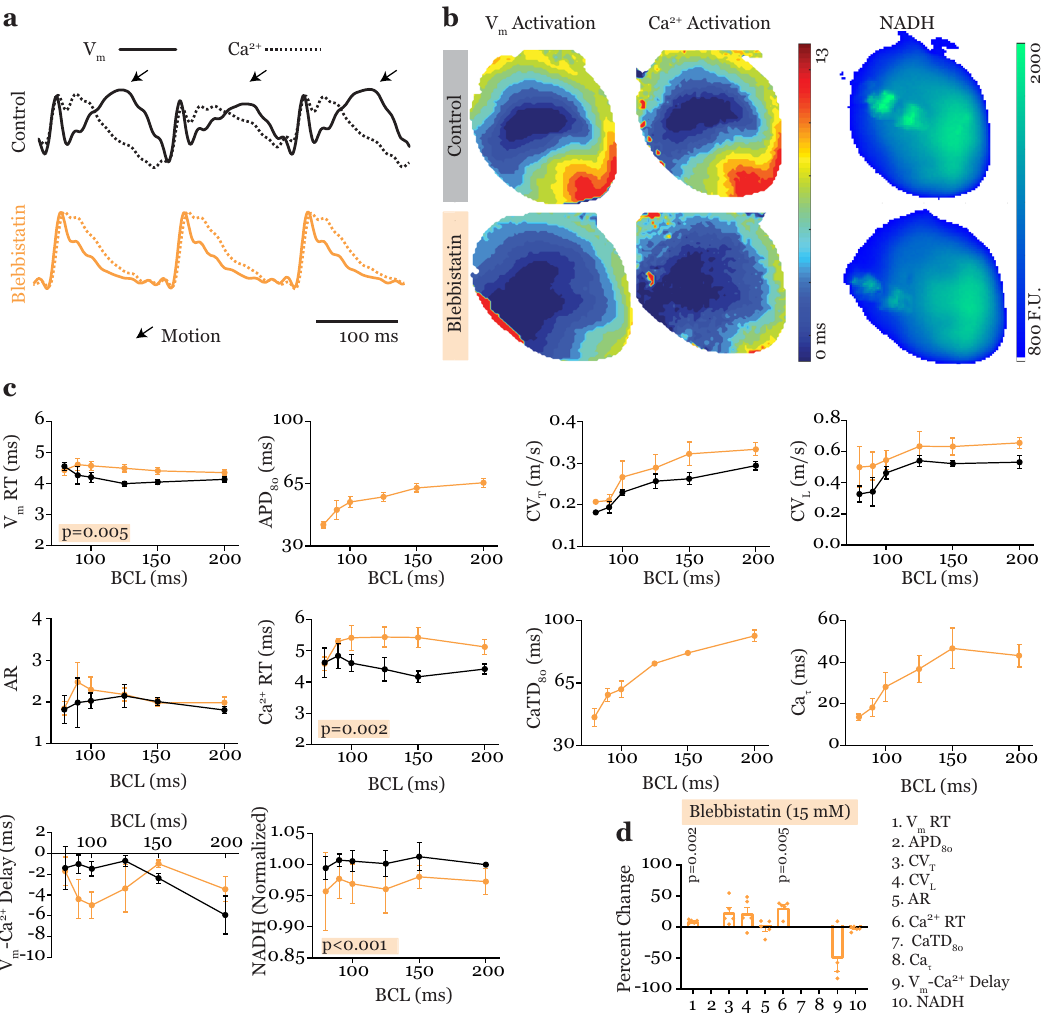
Fig. 2 Electromechanical uncoupling in triple-parametric optical mapping. a Representative traces of V m and Ca 2 + (solid and dotted traces, respectively) were recorded without (Control, black) and with the electromechanical uncoupler Blebbistatin (15 μ M, orange). b Representative V m activation maps (left), Ca 2 + activation maps (middle), and NADH intensity maps (right) recorded during Control and Blebbistatin treatment. All maps were recorded from the same heart, the top three maps were from simultaneous recording during Control and the bottom three from simultaneous recording during Blebbistatin treatment. Slightly different silhouettes, particularly around the boundaries is due to different background noise removal levels using a thresholding algorithm. These boundary pixels were not used in the analysis. c Summary restitution properties of the ten parameters measured simultaneously by triple-parametric optical mapping. d Ten-parameter panel showing the effects of Blebbistatin on cardiac physiology at 150 ms BCL, reported as percent change from Control. Data presented as mean ± s.e.m., n = 5 hearts, Least squares regression analysis was performed for data in panel ( c ) to detect signi fi cant differences in parameters during Control versus Blebbistatin treatment and all signi fi cant p values are reported. Two-tailed, paired t -tests were performed for data in panel ( d ) to detect signi fi cant change induced by Blebbistatin compared to Control and all signi fi cant p values are reported. Benjamini – Hochberg correction was applied to account for multiple